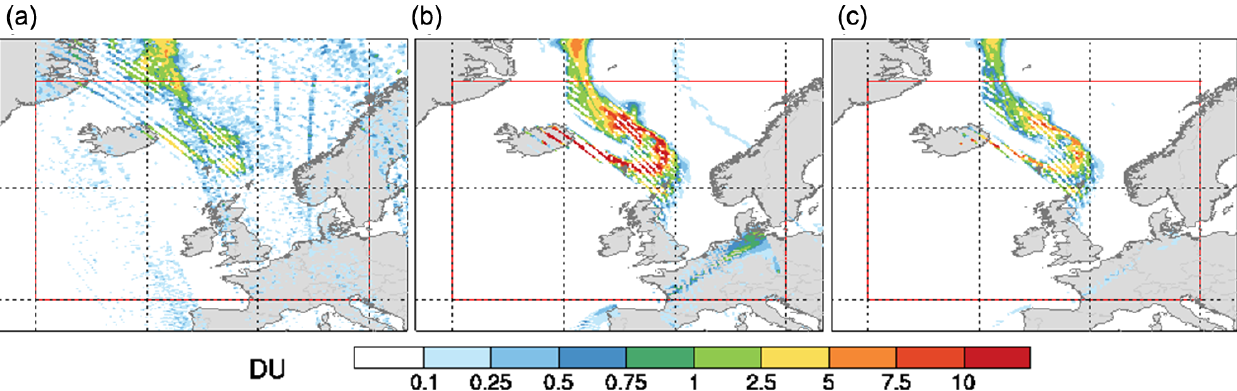
Figure 1. SO 2 column density: (a) for the satellite swaths on 24 September 2014; (b) for corresponding, consistently colocated original model data in the base simulation bas_hol; (c) for these model data with the satellite averaging kernel applied. The red box indicates the area where the statistics of satellite and model data in Figs. 2 and 3 are